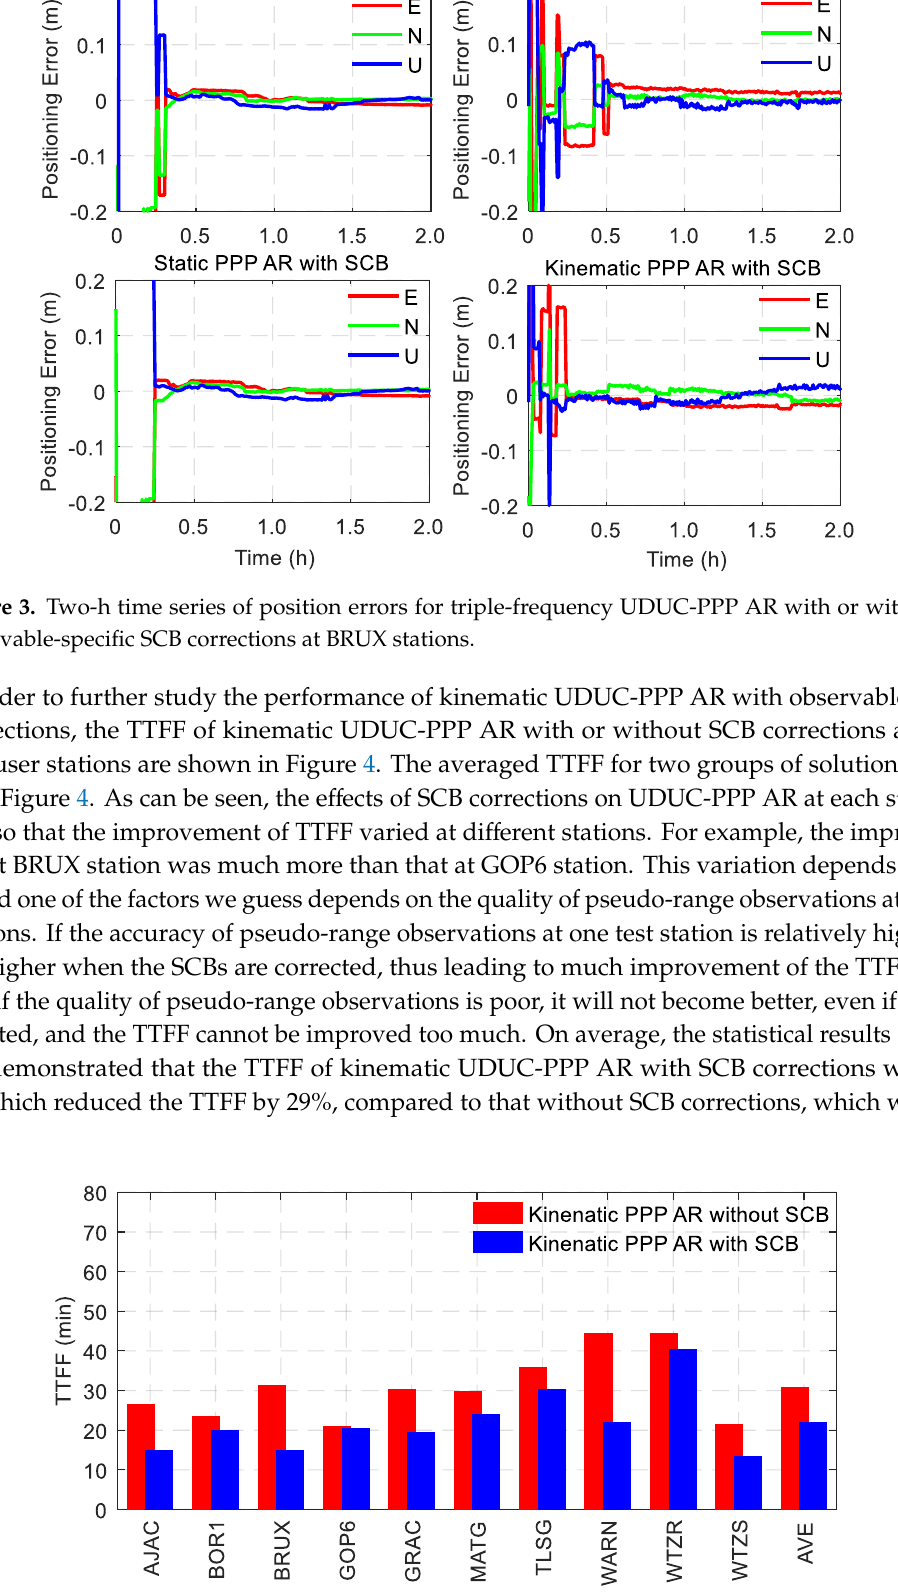
Figure 4. Time-to-first-fix (TTFF) of kinematic UDUC-PPP AR with or without observable-specific satellite code bias (SCB) corrections at ten